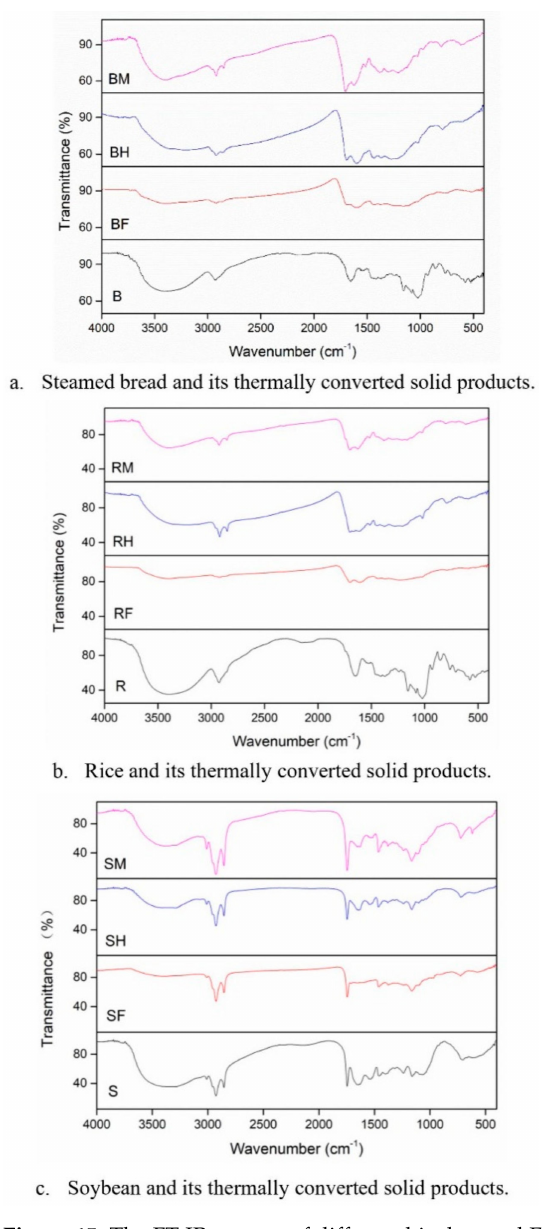
Figure 15. The FT-IR spectra of different biochar and FW